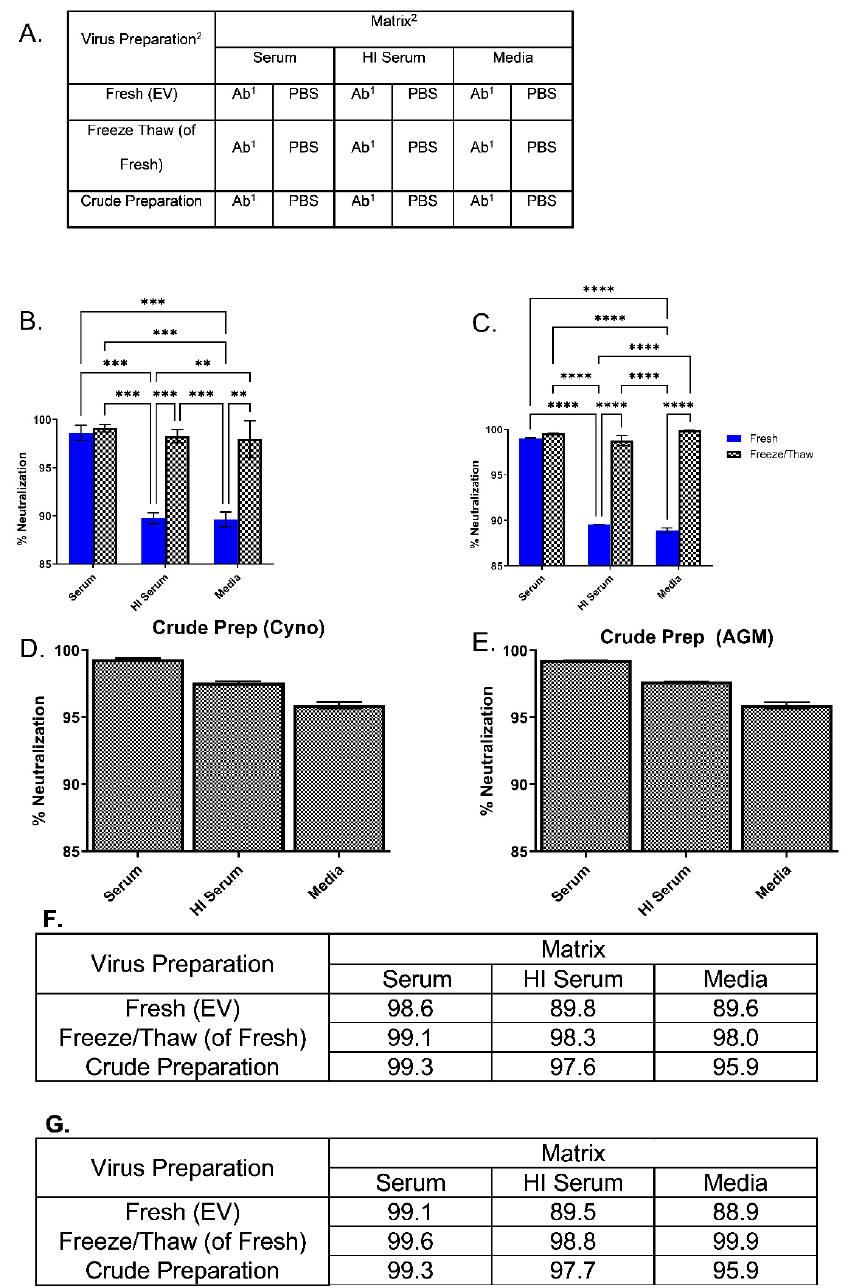
Figure 5. Effect of nonhuman primate sera on MV neutralization of freshly prepared and freeze/thawed preparations of monkeypox virus. ( A ) A general outline of the experimental design. ( B ) Fresh preparations of monkeypox virus were split and incubated with either cynomolgus